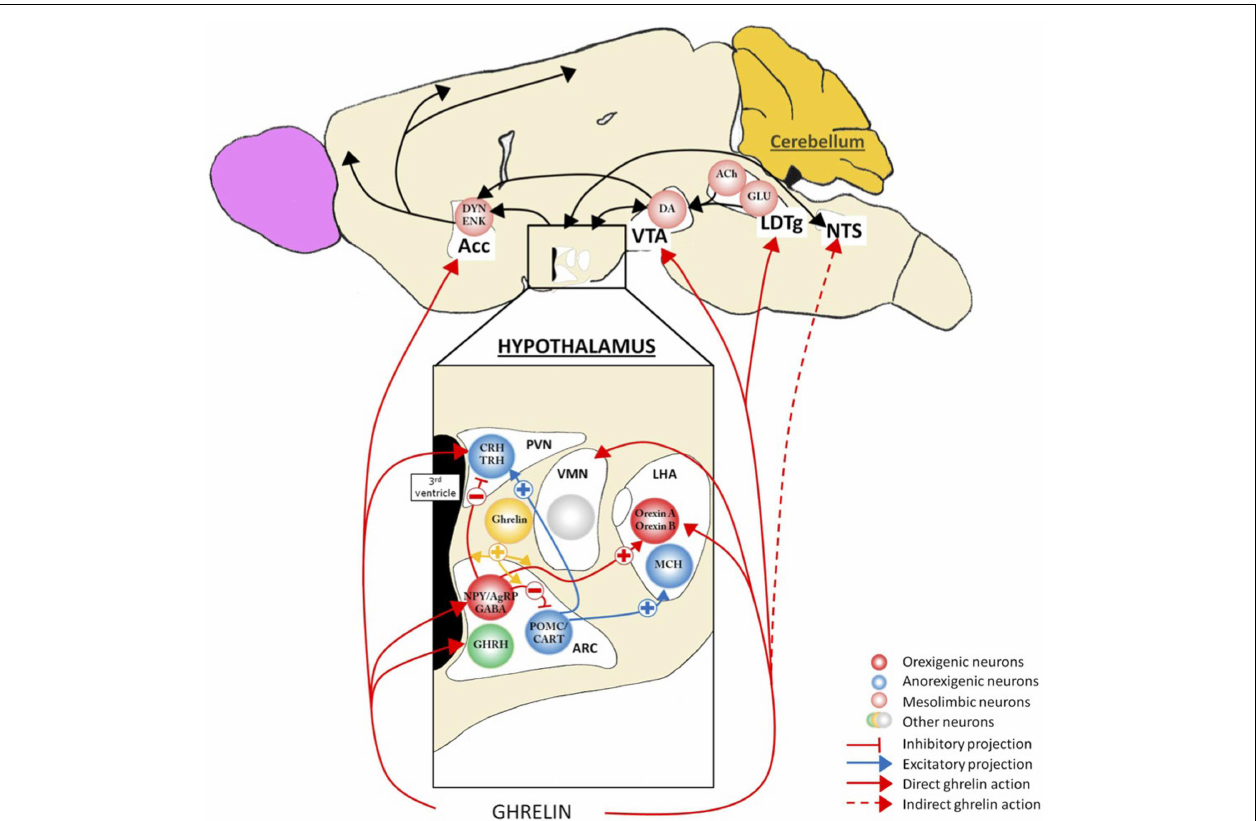
stimulate the food intake via either vagal nerve or area postrema, see Figure 4 . Acc, accumbens nucleus; ACh, acétylcholine; AgRP, agouti-related peptide; ARC, arcuate nucleus; CART, cocaine- and amphetamine-regulated transcript; CRH, corticotropin-releasing hormone; DA, dopamine; DYN, dynorphin; ENK, enkephalin; GABA, γ -aminobutyric acid; GHRH growth-hormone-releasing hormone; GLU, glutamate; LDTg, laterodorsal tegmental area; LHA, lateral hypothalamic area; MCH, melanin-concentrating hormone; NPY, neuropeptideY; NTS, nucleus tractus solitarius; POMC, pro-opiomelanocortin; PVN, paraventricular nucleus;TRH, thyrotropin releasing hormone;VMH, ventromedial nucleus;VTA, ventral tegmental